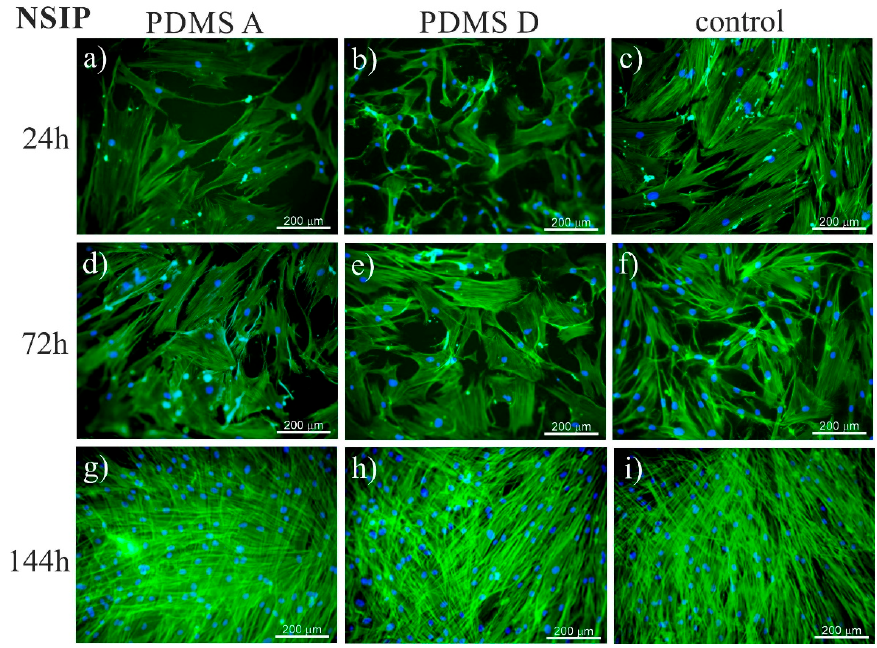
Figure 2. Fluorescence micrographs of the actin cytoskeleton (green) and nuclei (blue), recorded for NSIP-derived fibroblasts cultured for 24 ( a – c ), 72 ( d – f ), and 144h ( g – i ) on PDMS A ( a , d , g ), PDMS D ( b , e , h ), and control samples (glass, ( c , f , i )).